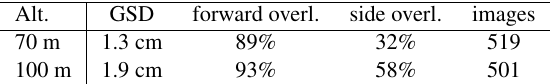
Table 1: Average ground sampling distance (GSD), forward and side overlap as well as the total number of images for both data sets.